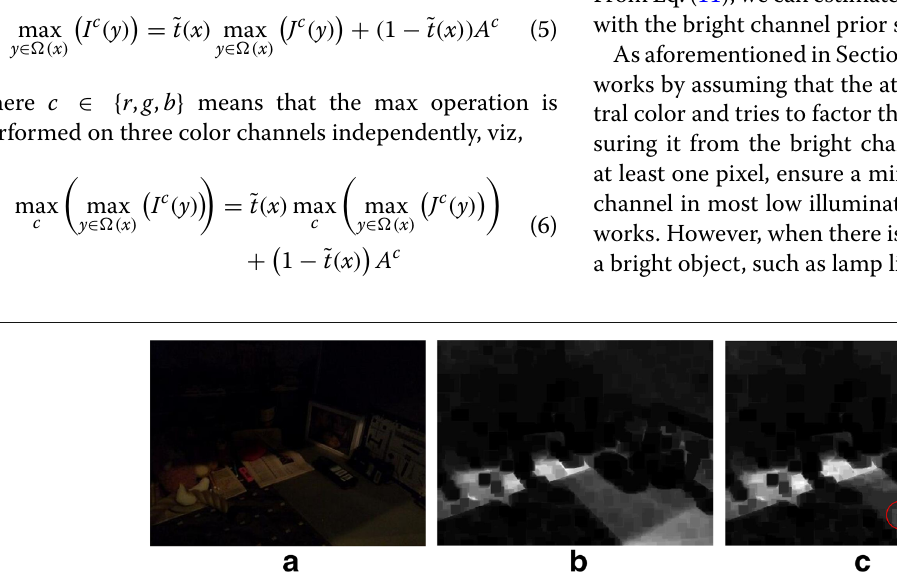
Fig. 6 Illustration transmission estimation result via dual channel prior. a Input image. b Transmission estimated with bright channel. c Transmission estimated with dual channel